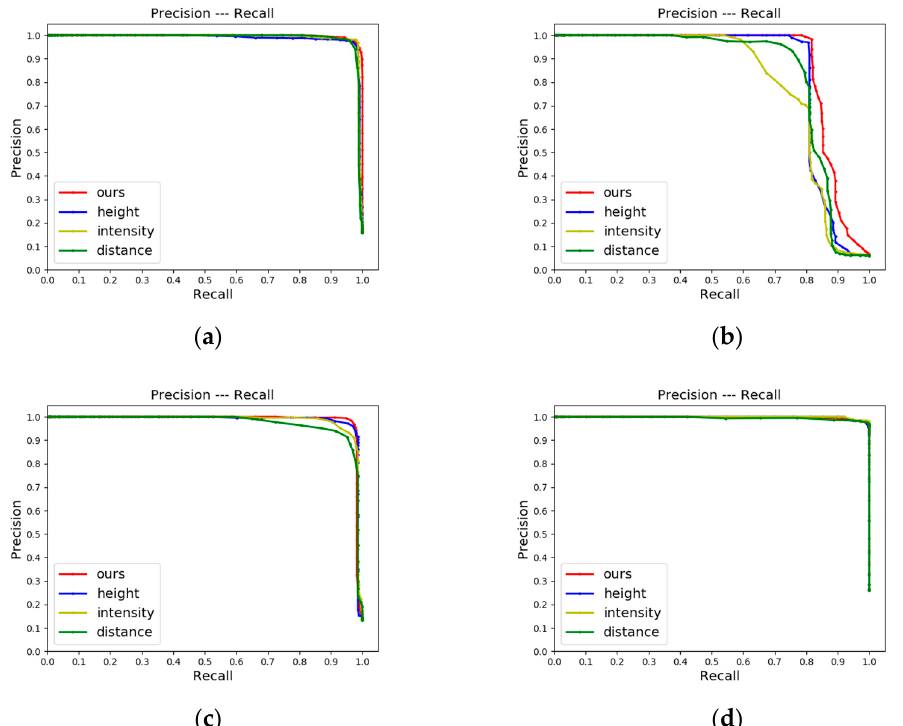
Figure 11. P-R curves of CMCD, single-channel projection of height, intensity, and distance on KITTI Odometry sequences: ( a ) The P-R curve of KITTI-00; ( b ) The P-R curve of KITTI-02; ( c ) The P-R curve of KITTI-05; ( d ) The P-R curve of KITTI-06.